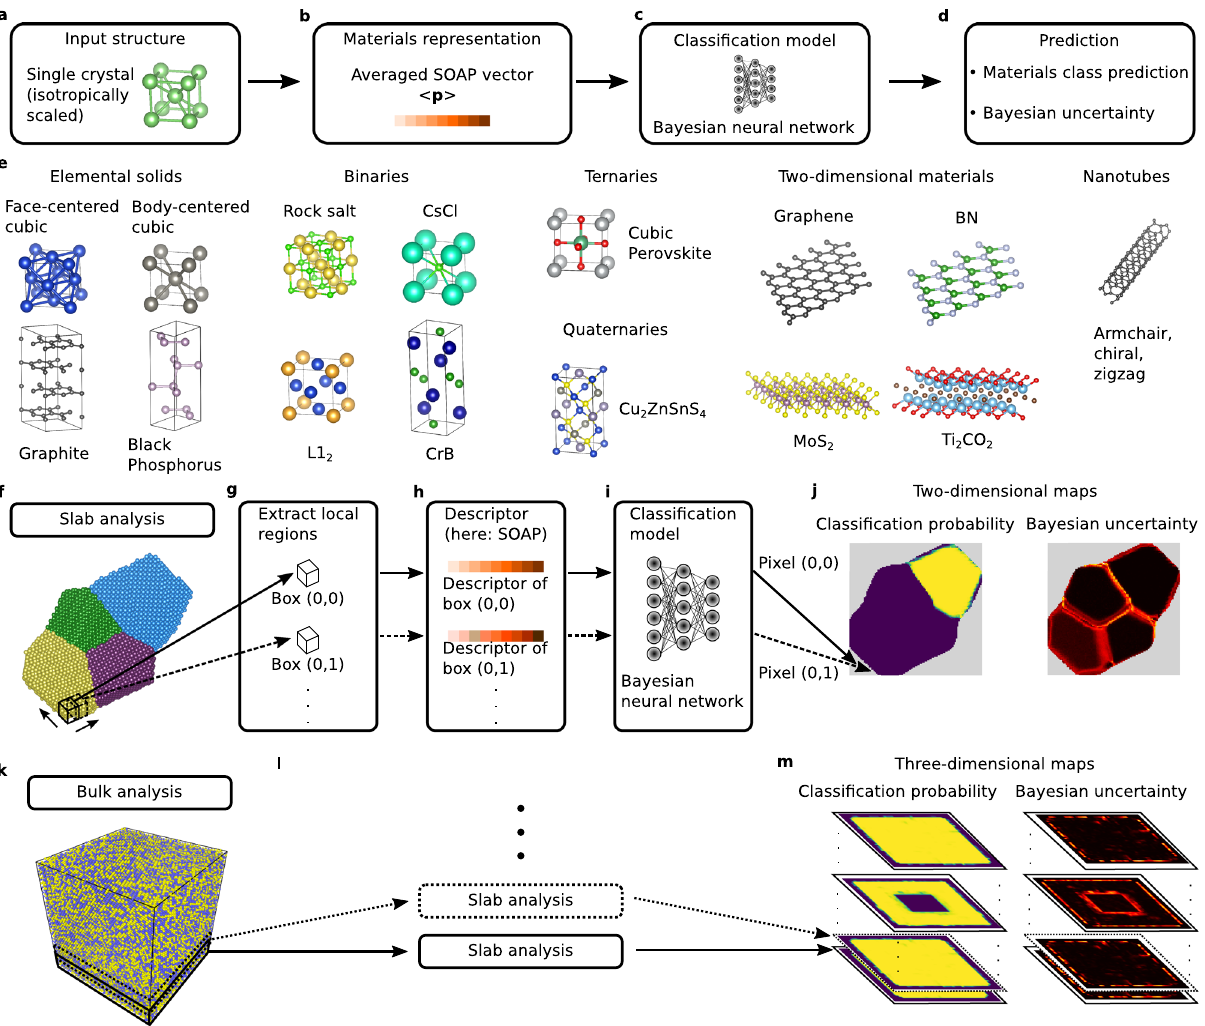
Fig. 1 Schematic overview of single- and polycrystal characterization framework. a – d Prediction pipeline of the single-crystal classi fi cation model ARISE (ARti fi cial-Intelligence-based Structure Evaluation). In this work, we employ the smooth-overlap-of-atomic-positions (SOAP) descriptor. e Examples of crystallographic prototypes included in the training set. f – m Polycrystal classi fi cation framework strided pattern matching (SPM) for slab-like ( f – j ) and bulk systems ( k – m